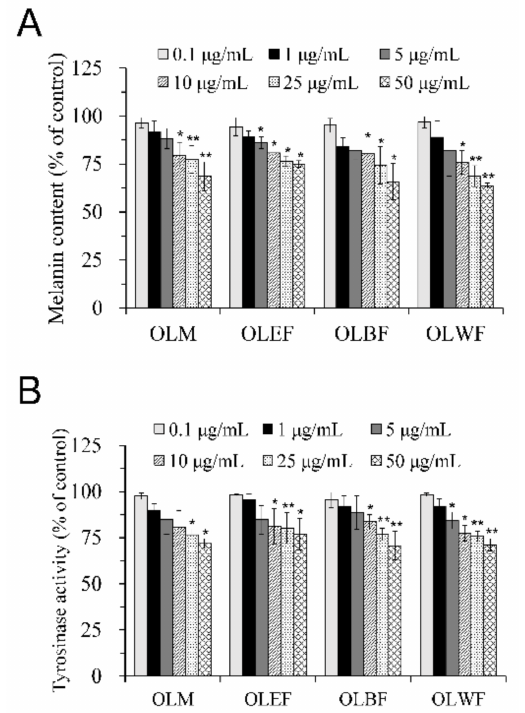
Figure 3. Inhibitory effects of OLM and its different soluble fractions on the cellular melanin production ( A ) and tyrosinase activity ( B ) in B16-F10 cells. Melanin production and tyrosinase activity in B16-F10 cells treated with vehicle control or non-cytotoxic concentrations (0.1–50 µ g/mL) of OLM and its fractions for 48 h were measured. The melanin content and tyrosinase activity were represented as a percentage of the content in control. Values are the mean ± SD of three independent experiments. * p < 0.05, ** p < 0.01, compared with control